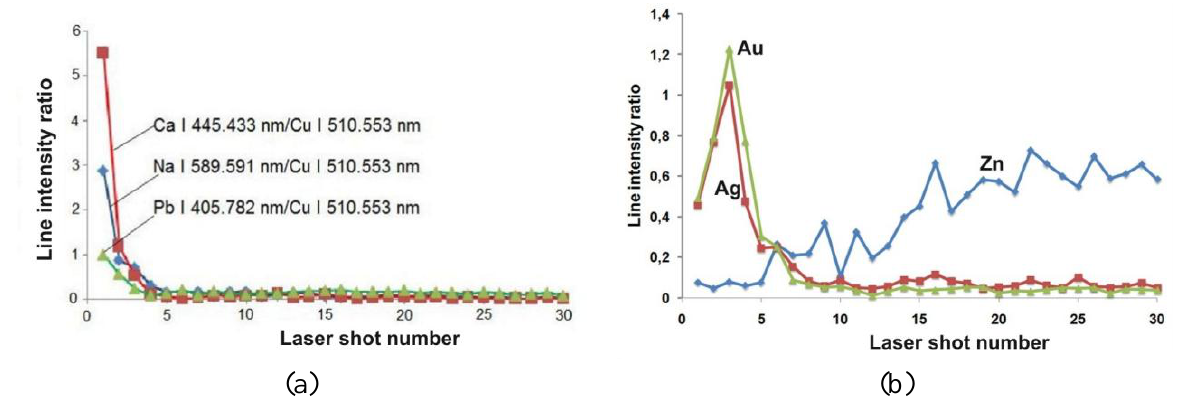
Figure 14. Results of in-depth LIBS analysis at of the laurel putto leaf: (a) distribution of ―environmental elements‖ (deposit); (b) distribution of gilding elements and